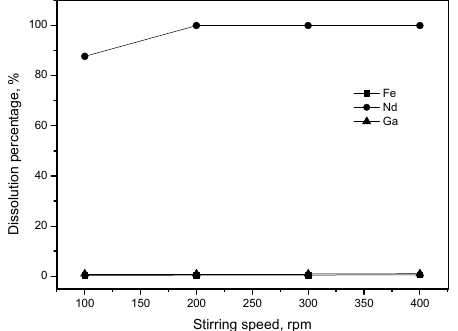
Figure 9. Effect of stirring speed on the leaching of the oxide mixtures by 1.0 M HCl in EG. Operation conditions: pulp density = 50 g/L, T = 25 °C, time = 120 min.